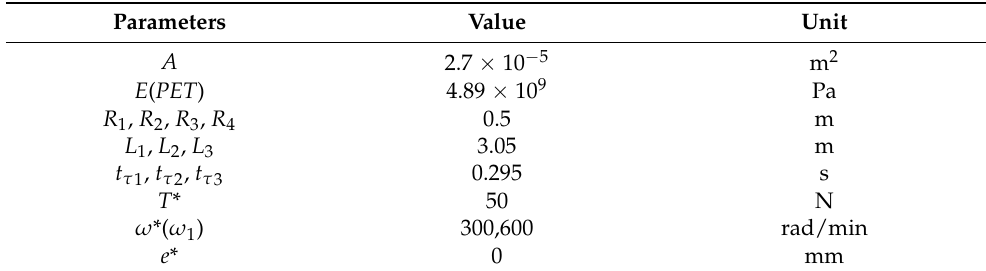
Table 1. Parameters of the model.